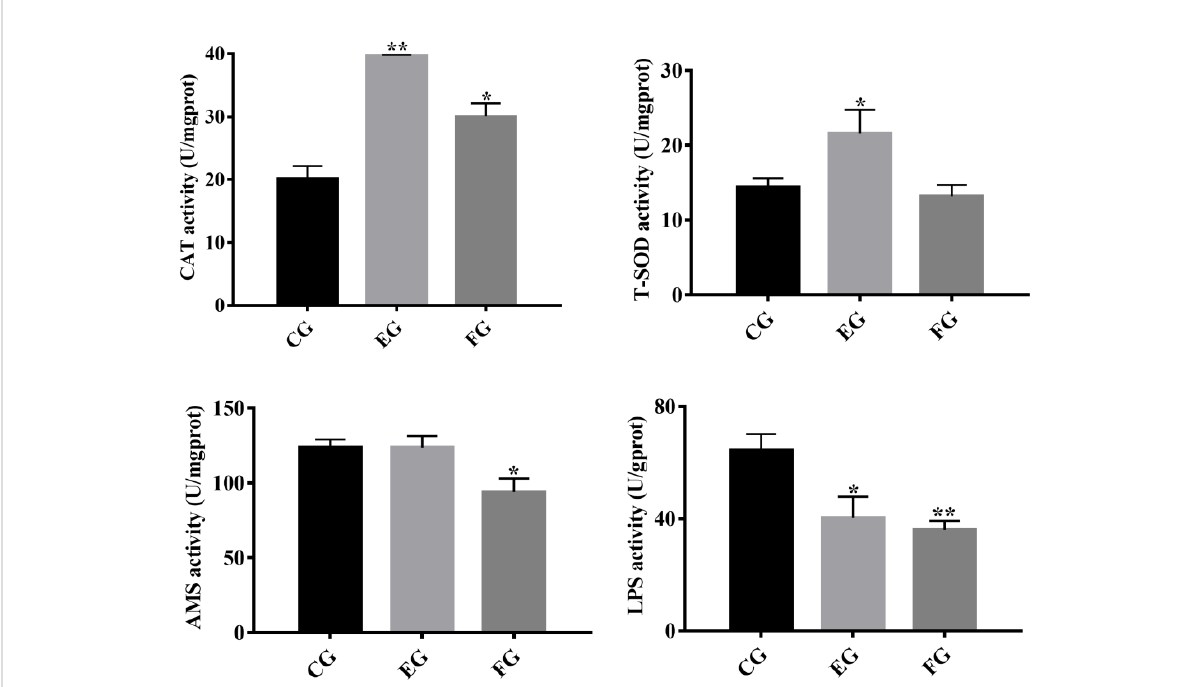
FIGURE 1 Antioxidative and digestive enzyme indices in the midguts of grass carp fed with different treatments (control (CG), enro fl oxacin (EG) and fl orfenicol (FG)) after two weeks. Catalase (CAT), total superoxide dismutase (T-SOD), amylase (AMS) and lipase (LPS) were selected, and the bars show the mean ± SD (n = 3). The different symbols indicate signi fi cant differences (*, p < 0.05; **, p < 0.01) among the